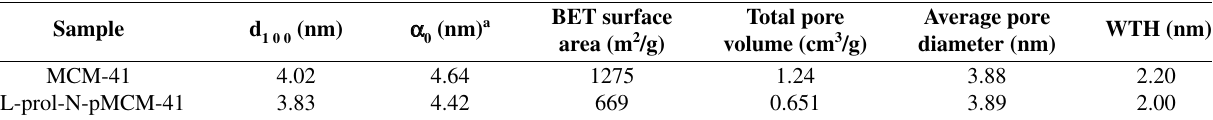
Table 1. Surface characteristics of ordered mesoporous solids Sample